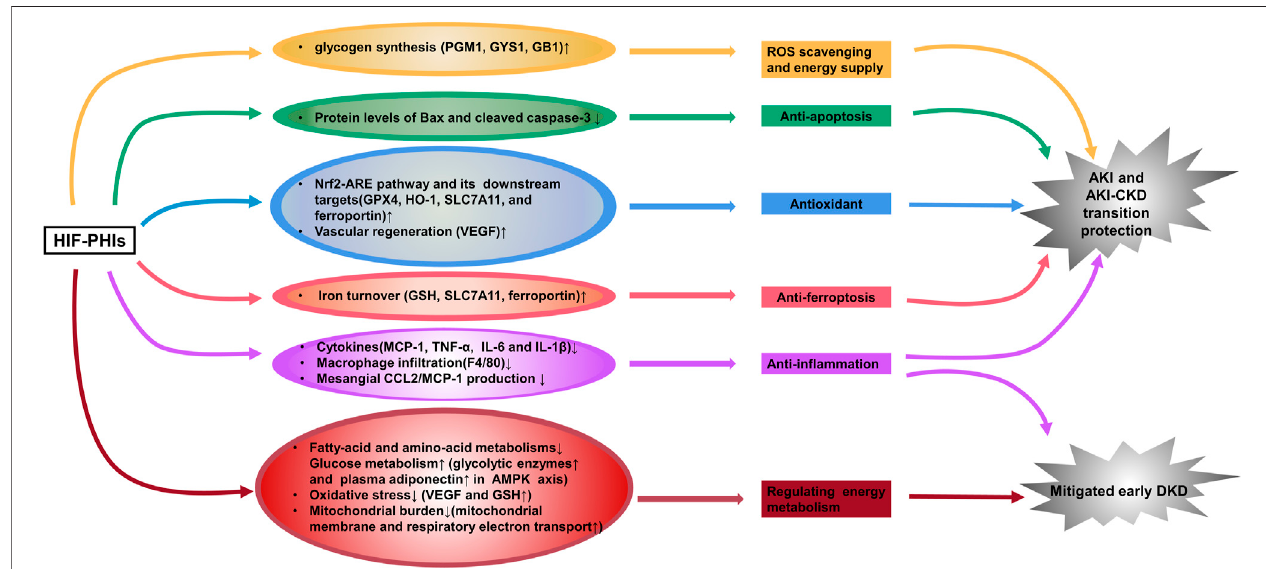
FIGURE 1 | HIF-PHIs protect against acute kidney injury and incipient diabetic kidney disease. HIF-PHIs upregulate HIF expression in ischemia-, hypoxia- or toxication-induced AKI models and transactivate multiple target genesinvolved in anti-in fl ammation, anti-apoptosis, anti-oxidant, anti-ferroptosis, vascular regeneration and glycogen synthesis pathways to play a renal protective role. In diabetic kidneys, fatty acid and amino acid metabolism was upregulated, whereas HIF-PHIs downregulated these pathways and upregulated glucose metabolism. HIF-PHIs showed anti-in fl ammation effect, and counteract energy metabolism disorders, thus alleviating early diabetic kidney pathology. HIF, hypoxia inducible factor; HIF-PHIs, HIF prolyl hydroxylase domain enzyme inhibitors; AKI, acute kidney injury; CKD, chronic kidney disease; DKD, diabetic kidney disease; MCP-1, monocyte chemoattractant protein-1; TNF- α , tumor necrosis factor alpha; IL-6, interleukin-6; IL-1 β , interleukin-1 beta; GPX4, glutathione peroxidase 4; HO-1, Heme oxygenase 1; SLC7A11, solute carrier family 7 (anionic amino acid transporter light chain, xc-system), member 11; VEGF, vascular endothelial growth factor; GSH, glutathione; PGM1, phosphoglucomutase-1; GYS1, glycogen synthase 1; GB1, 1,4- α glucan branching